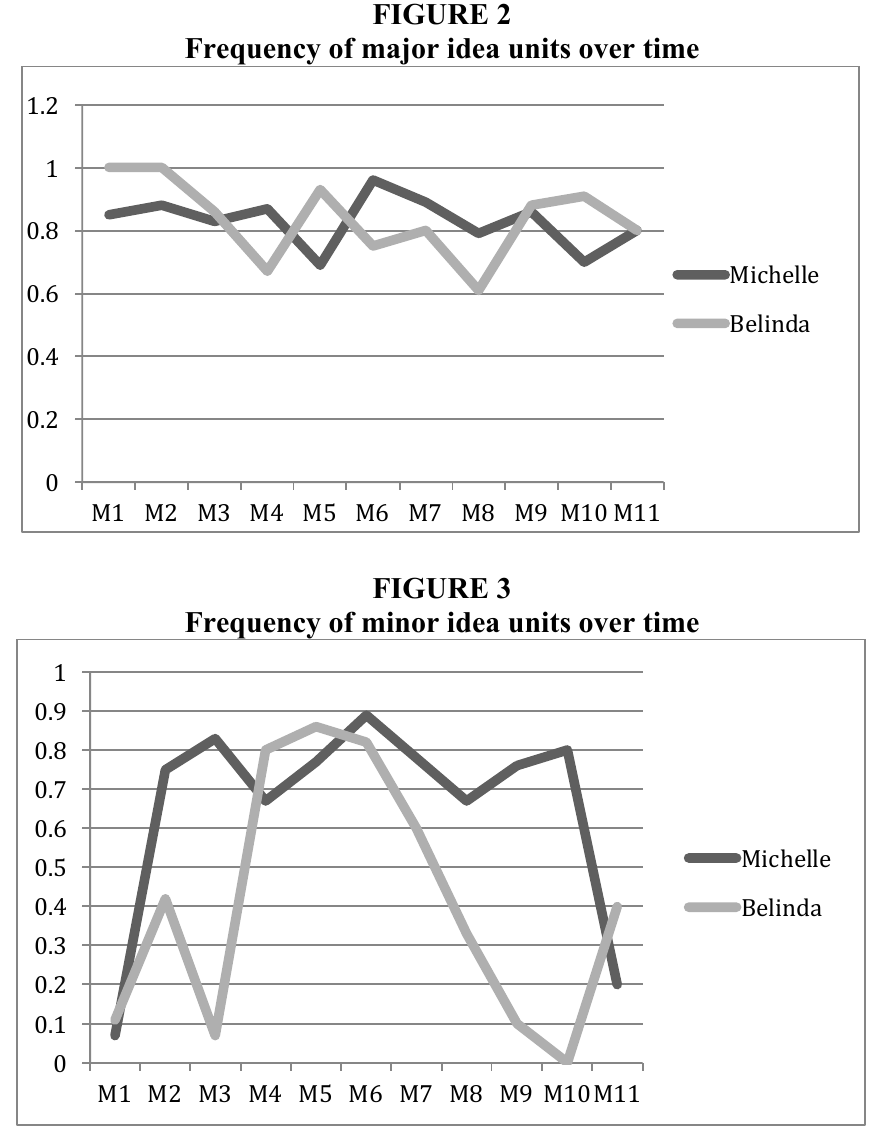
Frequency of major idea units over time